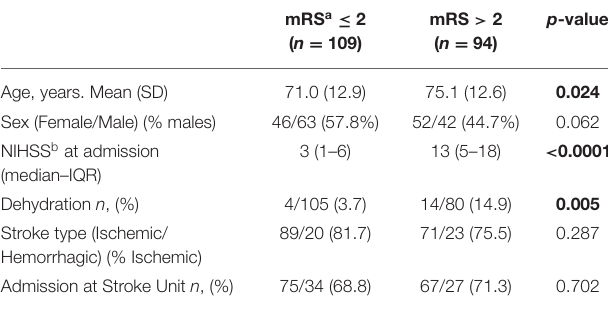
TABLE 2 | Comparison of clinical features in patients with good prognosis (mRS ≤ 2) and poor prognosis (mRS > 2) at discharge and p -values from statistical